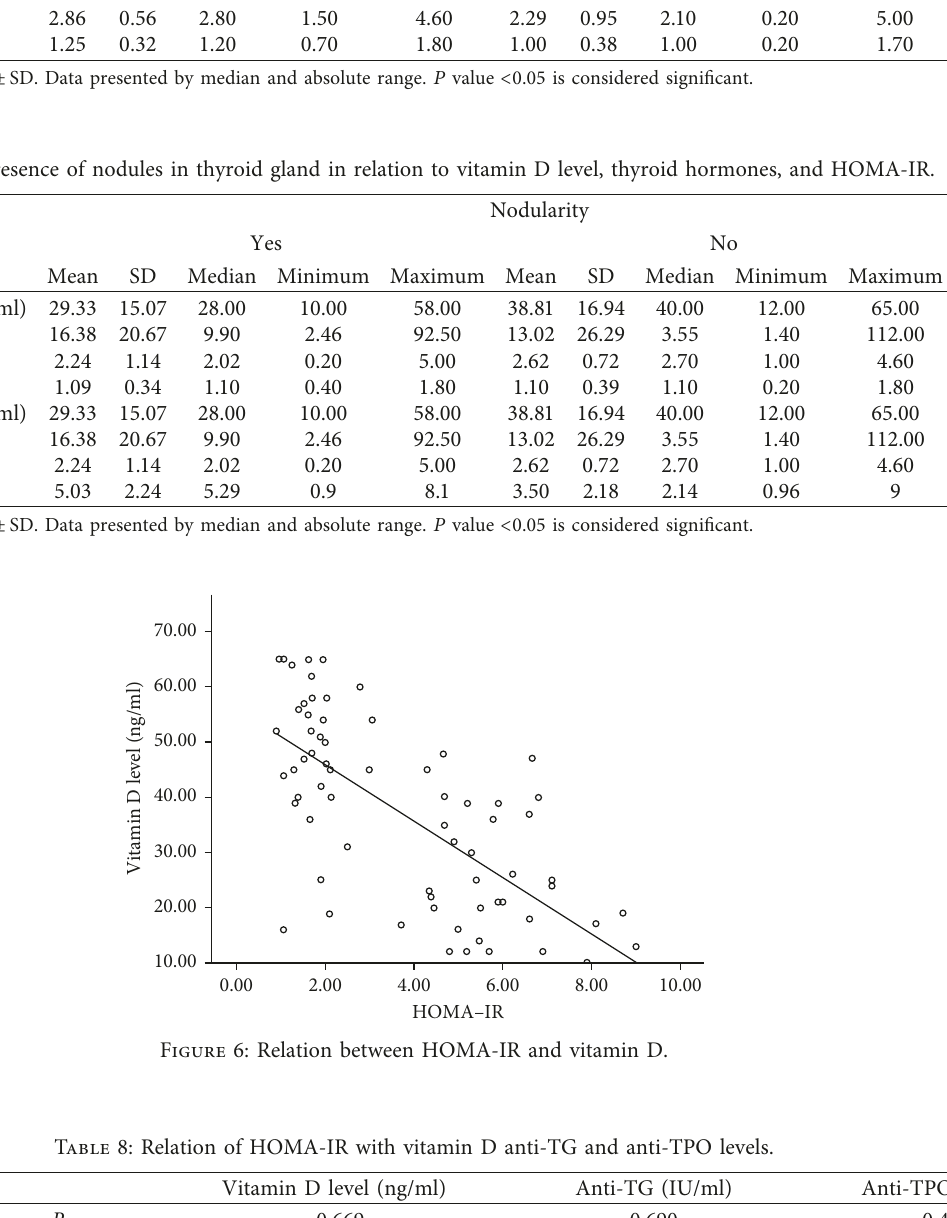
Table 6: Vascularity of thyroid gland in relation to vitamin D level and thyroid hormones. Vascularity Normal Increase Mean SD Median Minimum Maximum Mean SD Median Minimum Maximum Vitamin D level (ng/ml) 45.25 16.32